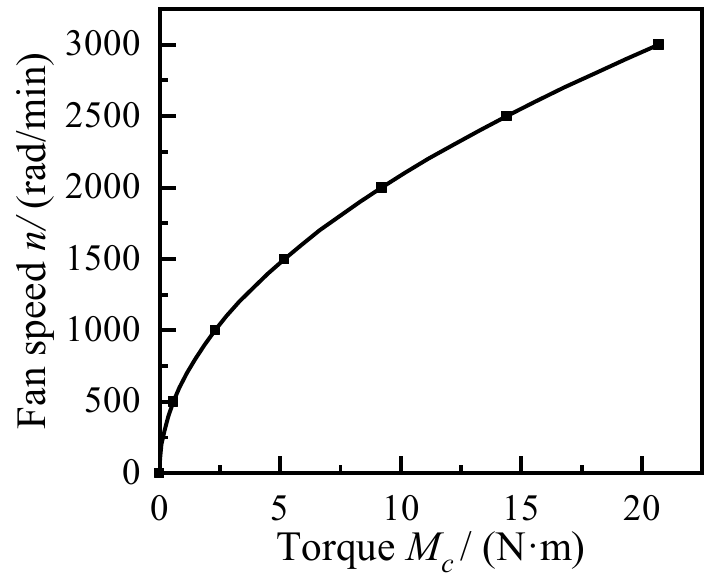
Figure 10. Torque versus rotation curves of SMA clutch. Combining Equation (11) and the relationship between SMA spring temperature and friction torque shown in Figure 9, the maximum speed that the SMA fan clutch can transmit at different temperatures is derived, where the relationship between clutch temperature and maximum speed is shown in Figure